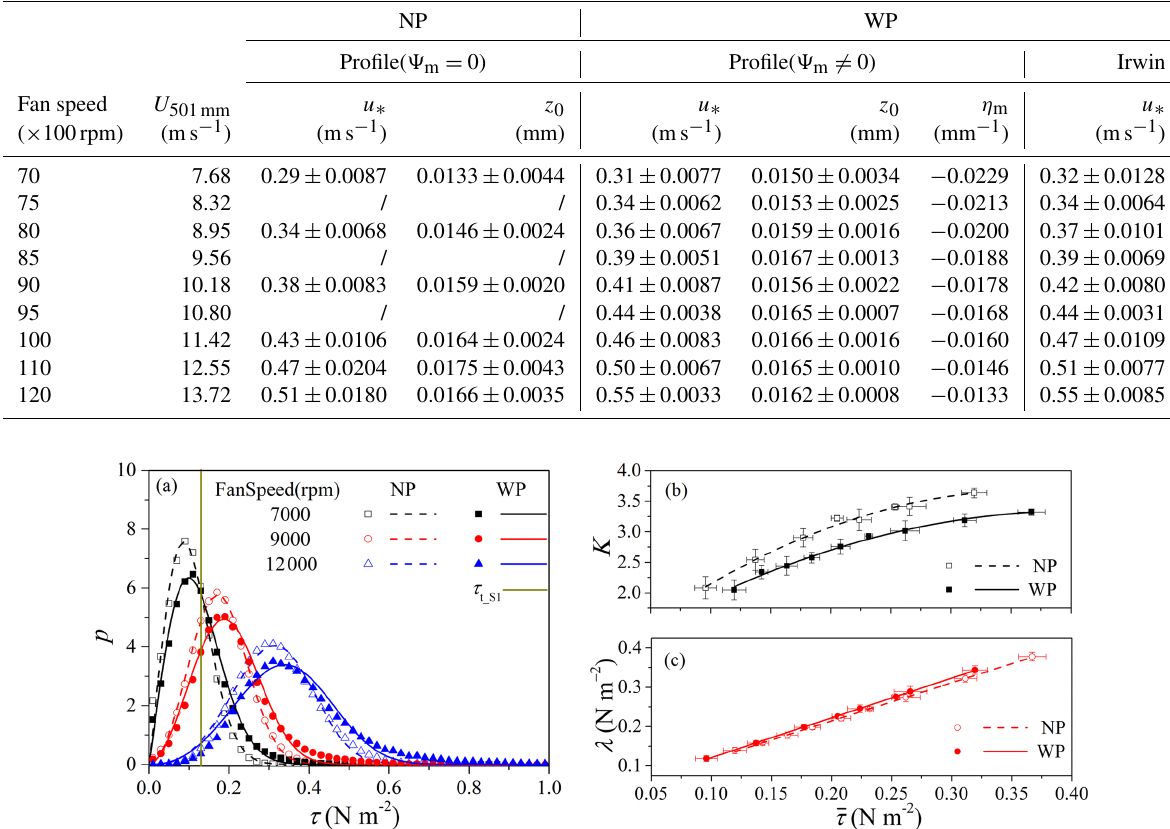
Table 2. Friction velocity u ∗ and roughness length z 0 estimated for runs with and with no forced perturbation and different wind-tunnel fan speeds ( R 2 = 99%). The Irwin sensor is calibrated based on the data of wind profiles under the NP condition.